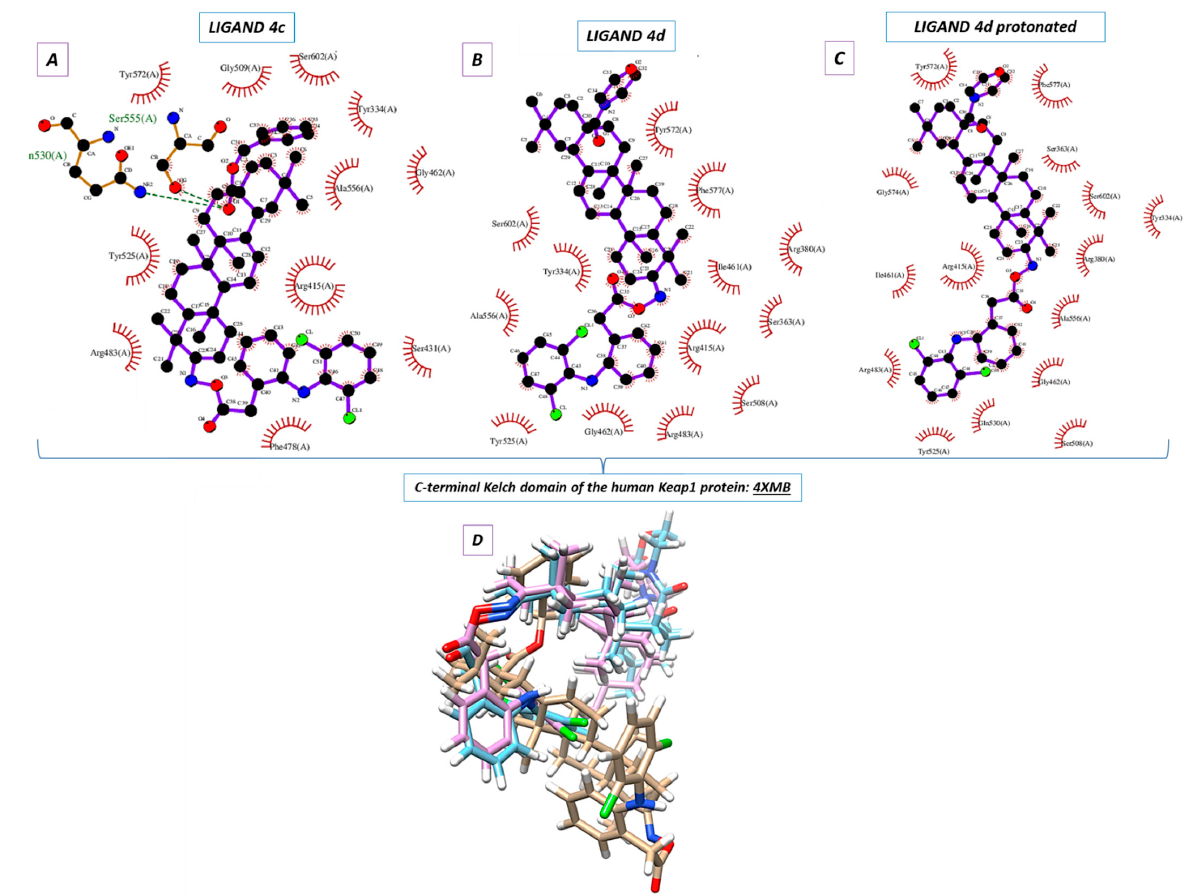
Table 2. Estimated binding affinity [kcal/mol] for the first two poses of the DCL–OAO derivative conjugates generated during the docking procedure; 4d_H —protonated form of the ( 4d ) deriva ‐ tive. Pose